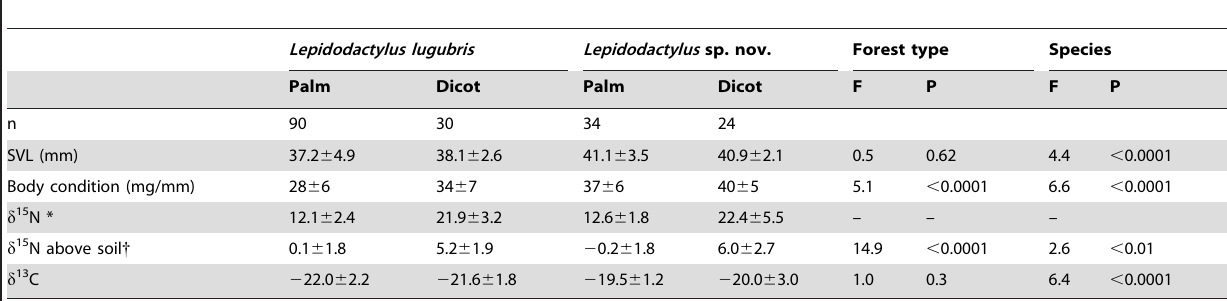
Table 1. Differences across species and forest type in gecko body size (SVL), body condition, and trophic position, and results of MANOVA.